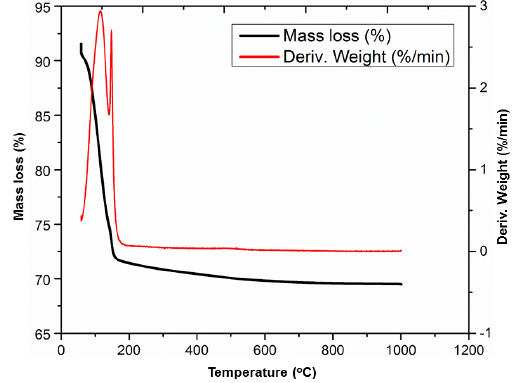
Figure 6. TGA thermogram on the post-cured (1 d at 60 ◦ C) paste with Al/P =